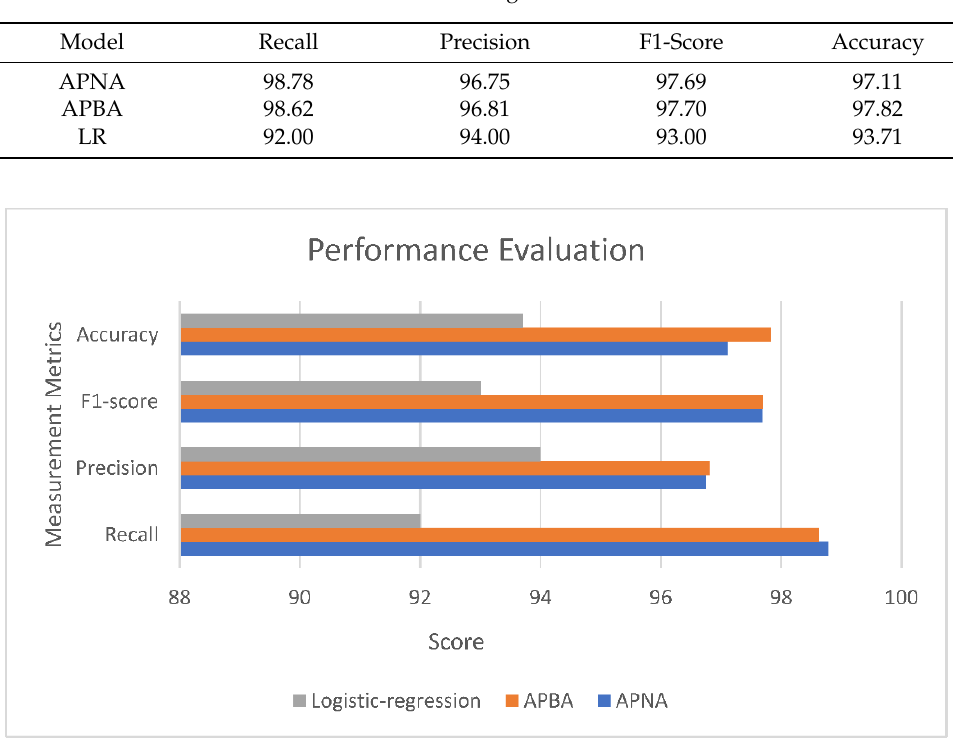
Table 2. Performance evaluation of machine learning models.